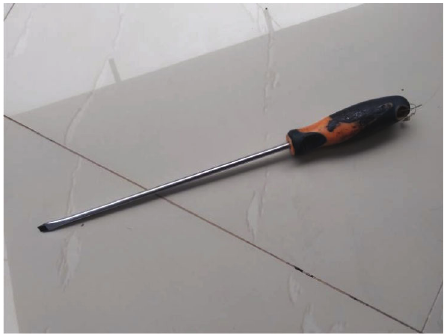
Figure 1: A similar standard 10-inch long screw driver used to in fl ict trauma in case one. As it is observed, it is long enough to transverse through anterior abdominal wall, intraperitoneal viscera up to retroperitoneal space traumatizing the